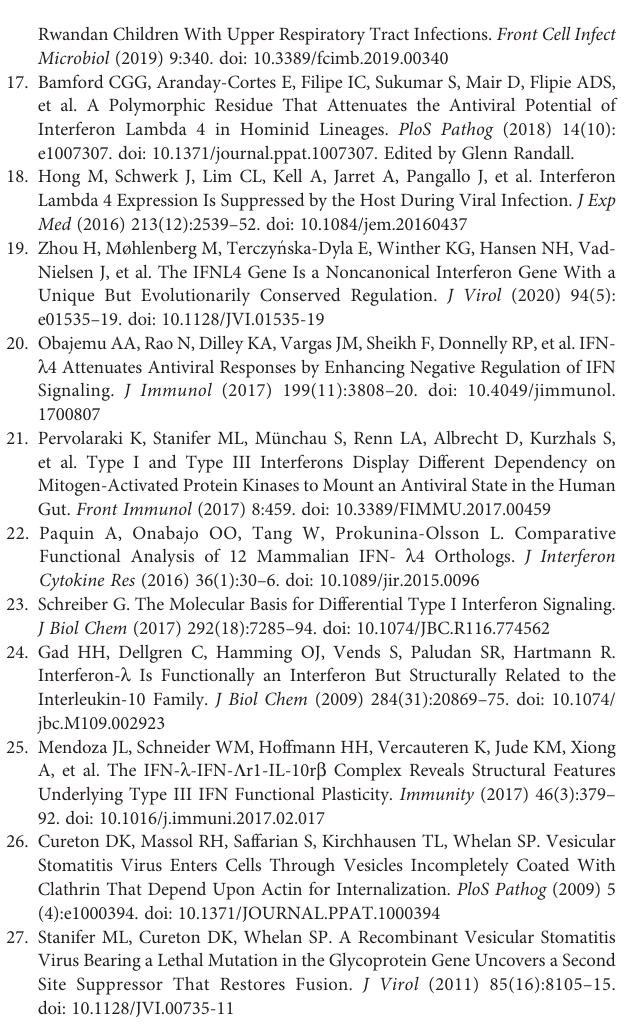
HiBiTvariants:WT(blue),P70S(purple),andK154E(cyan)atindicatedtimes(2,6or 24h) before supernatant was removed and rinsed with PBS before being replaced with fresh media not containing virus (A) . Stimulated cells were incubated until 24h after IFN l incubation prior to infection with EMCV and antiviral activity was read 24hpi (B) . Error bars represent the mean ± SEM from 2 biological